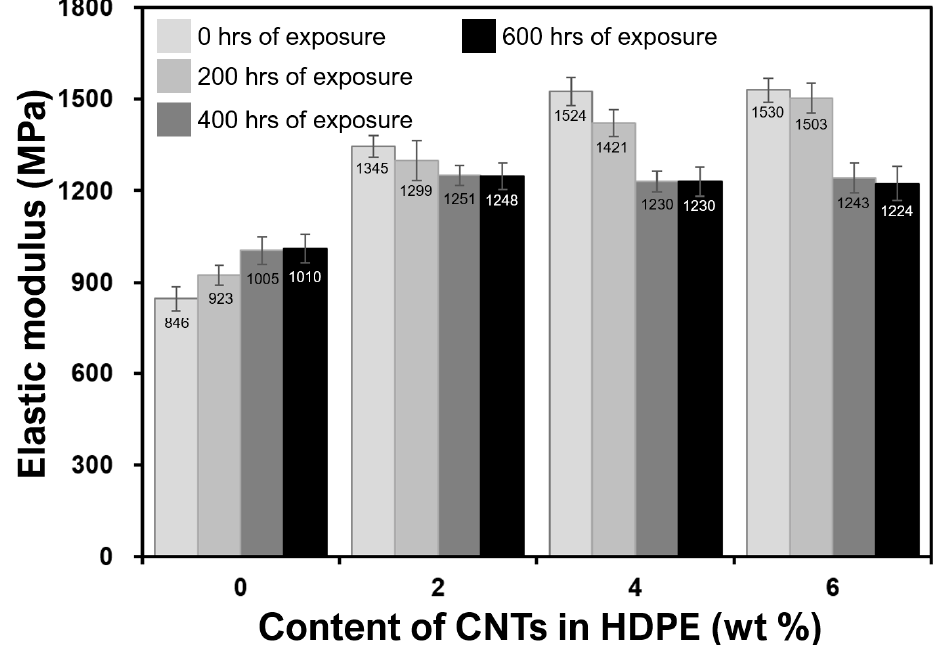
Figure 3. Effect of weathering on elastic moduli of monolithic and nanocomposite samples.